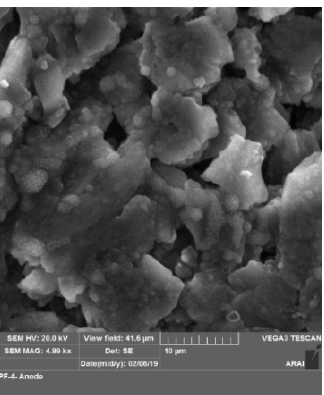
Figure 9. Nail-penetrated cell anode with location at centre (100% SoC).